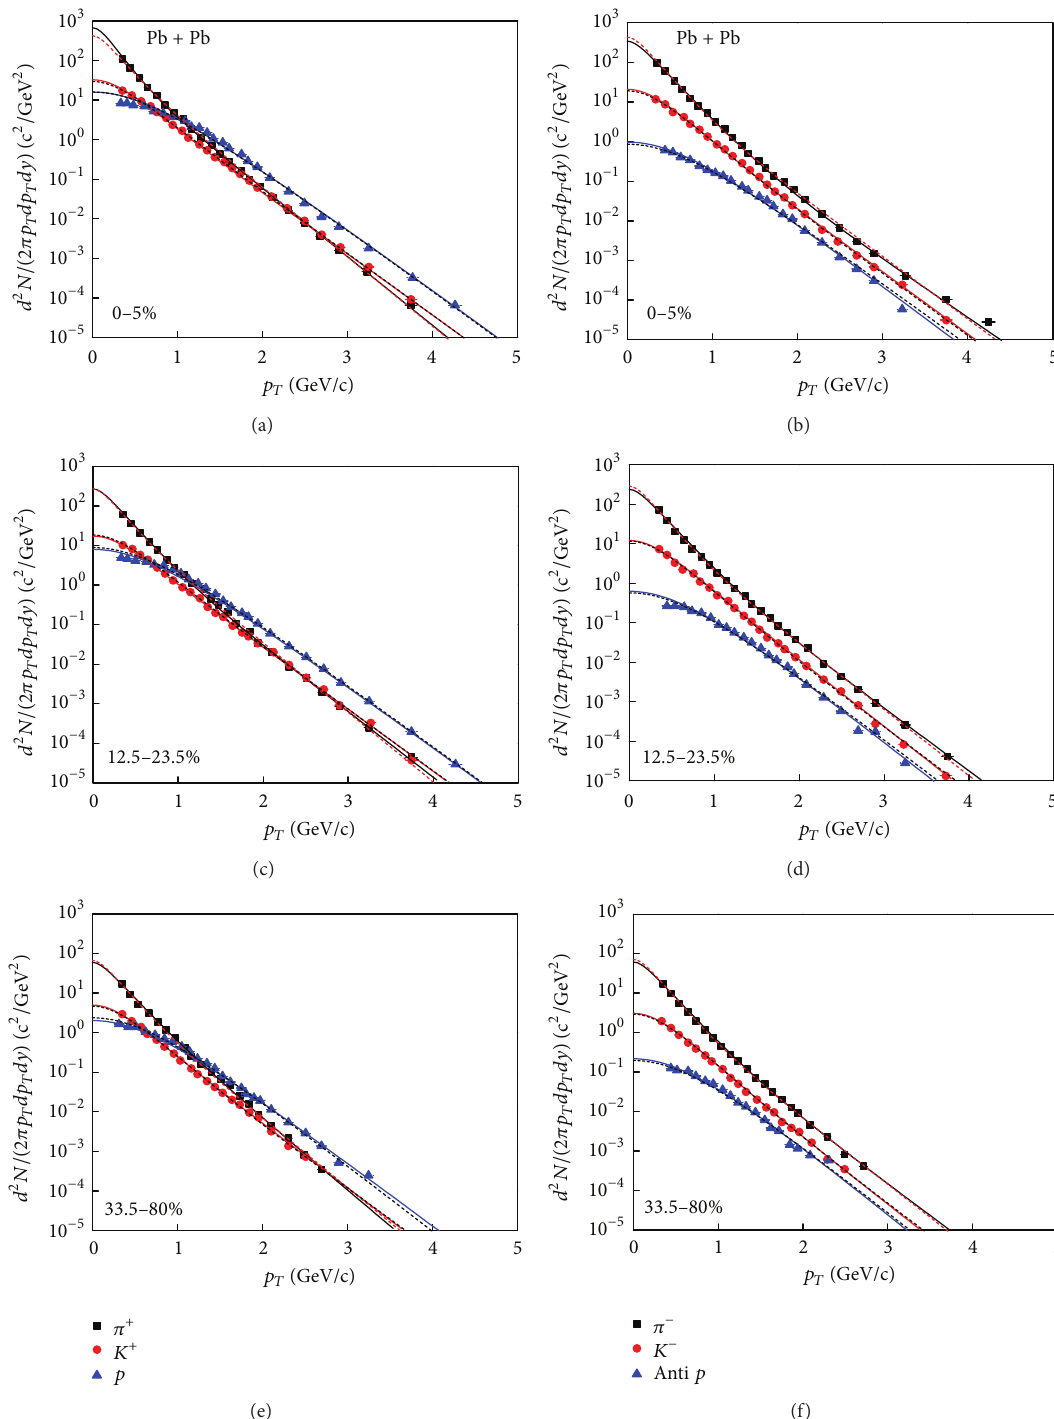
Figure 1: Transverse momentum spectra of (a, c, e) 𝜋 + (squares), 𝐾 + (circles), and 𝑝 (triangles), as well as (b, d, f) 𝜋 − (squares), 𝐾 − (circles), and 𝑝 (triangles) produced in Pb-Pb collisions at 17.3 GeV. (a)/(b), (c)/(d), and (e)/(f) correspond to the centralities of 0–5%, 12.5–23.5%, and 33.5–80%, respectively. The symbols represent the experimental data of the NA49 Collaboration [21], and the solid and dashed curves are the results of (14) and (15),